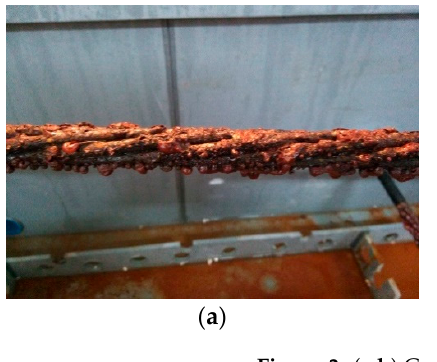
Figure 3. ( a,b ) Corrosion results of the steel strand.